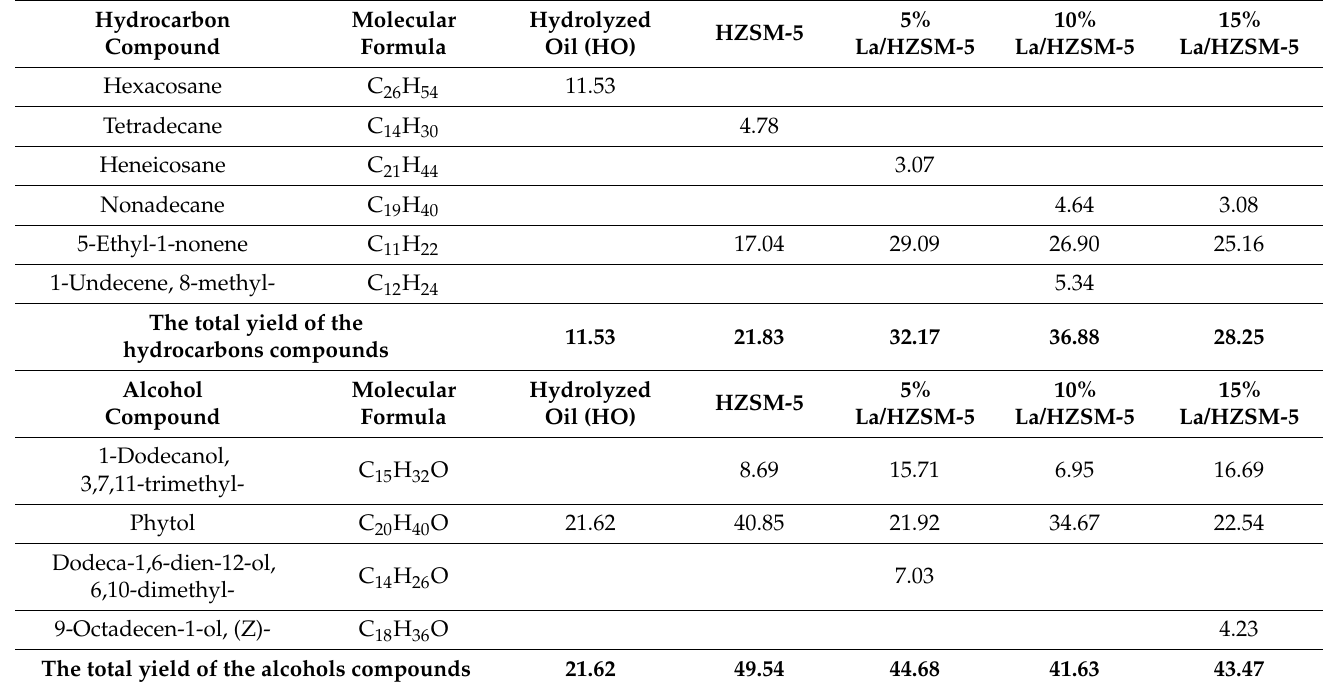
Table 5. The product-yield percentages of outstanding the hydrocarbons (alkanes and alkenes), and alcohols compounds from catalytic deoxygenation of the algal HO over the parent and lanthanum- modified zeolites at 300 ◦ C for 6 h under initial N 2 pressure of 7 bar, 1000 rpm, and 23.600 g of algal HO/3.540 g of the catalyst in the batch